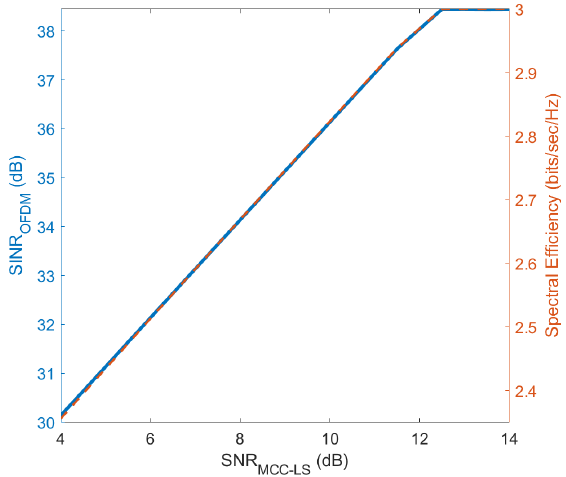
Figure 12. MCC power requirements for spectral efficiency optimization.